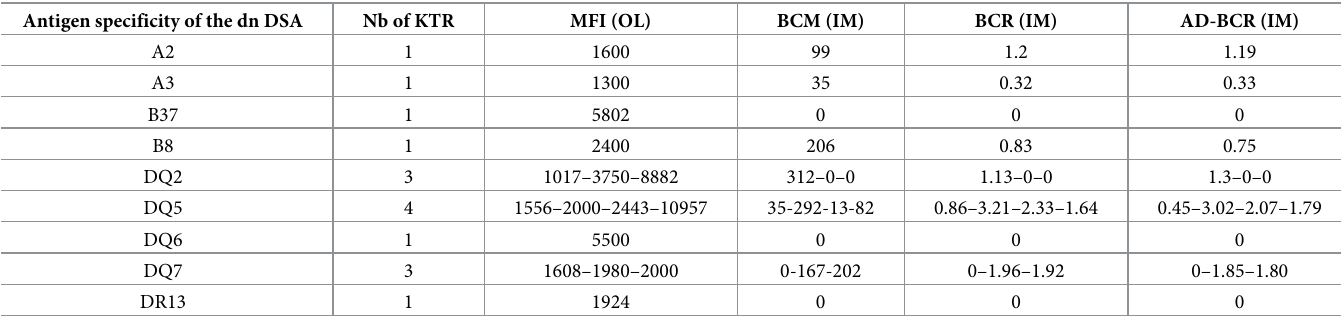
Table 1. Antigen specificity of the immunodominant DSA in patients with DSA positive with Labscreen SAB and negative with Lifecodes SAB. Antigen specificity of the dn DSA